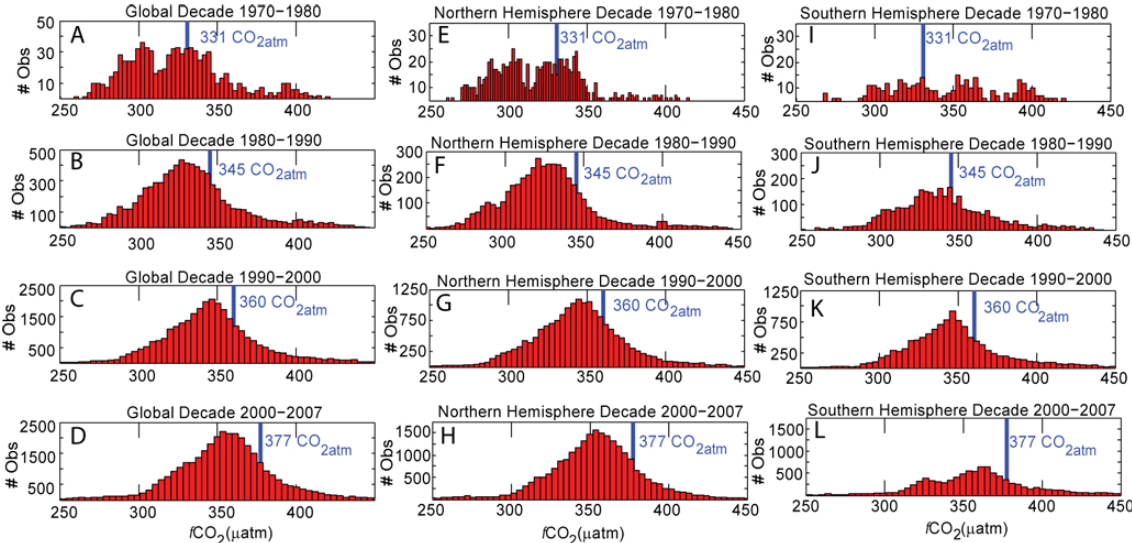
Figure 6. Histograms of the decadal mean f CO 2 values ( µ atm) for four di ff erent decades. (A) – (D) show the global values, (E) – (H) show the Northern Hemisphere, and (I) – (L) show the Southern Hemisphere values. The mean atmospheric CO 2 (ppmv) at Mauna Loa, HI for each decade is indicated by the blue bar (values from Pieter Tans, NOAA / ESRL (www.esrl.noaa.gov / gmd / ccgg / trends / ) and Ralph Keeling, Scripps Institution of Oceanography (www.scrippsco2.ucsd.edu /